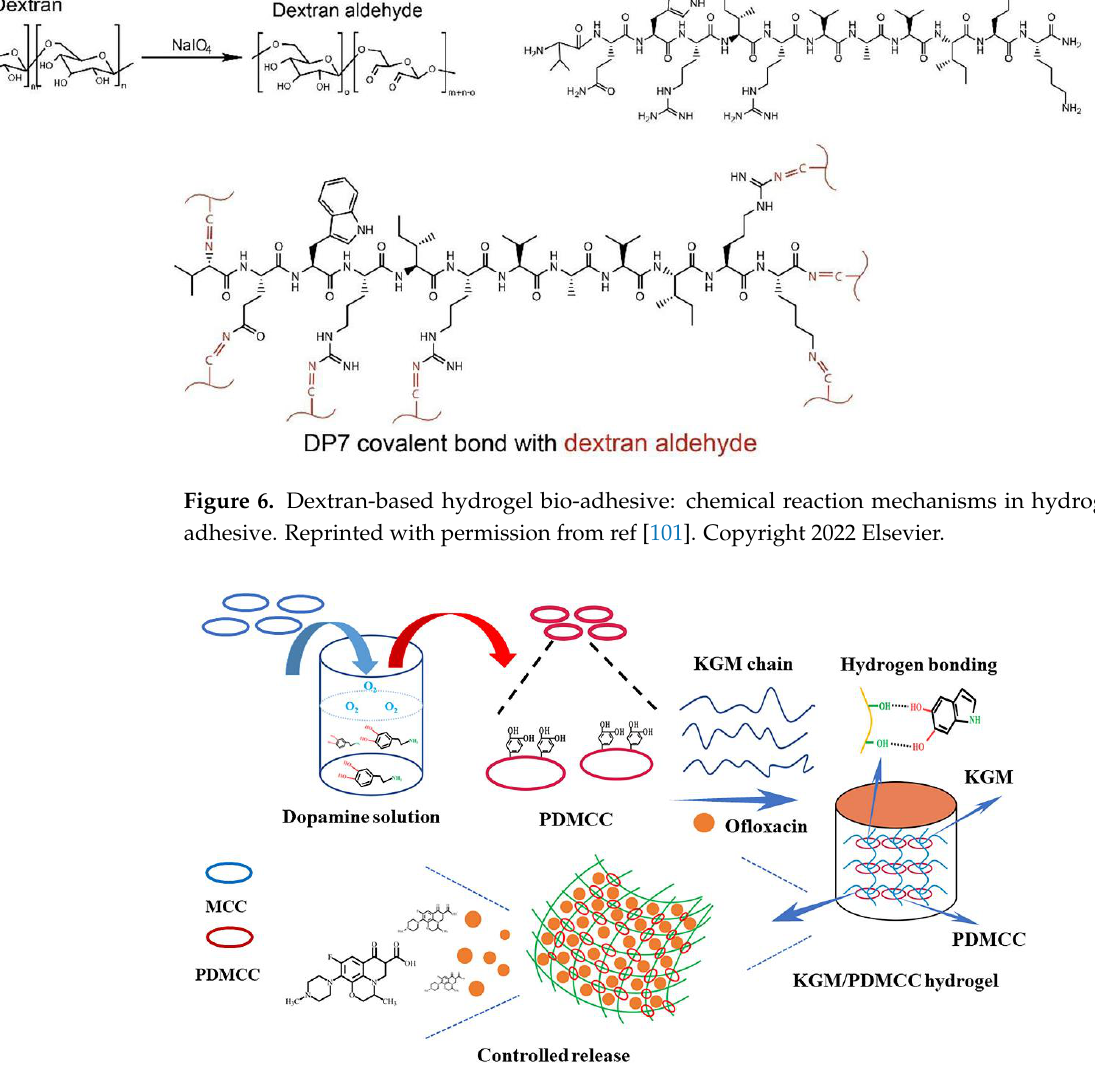
Figure 7. KGM-based hydrogel bio-adhesive: preparation diagram of KGM/PDMCC hydrogel bio- adhesive. Reprinted with permission from ref [144]. Copyright 2018 Elsevier. bio-adhesive. Reprinted with permission from ref [144]. Copyright 2018